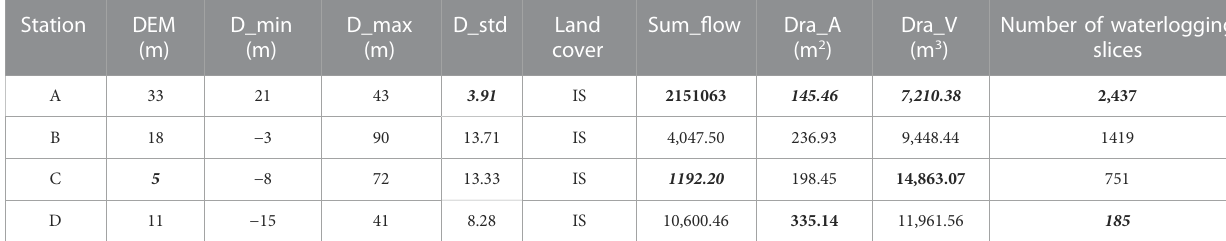
TABLE 6 Statistical results of geographical characteristics of the four